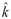
Comparison of SIS epidemic dynamics on networks with different statistical properties.Grey lines show 500 stochastic realizations of the individual-based model run on different random networks. Colored lines show the mean dynamics expected under the pairwise epidemic model (blue) versus the random mixing model (red). (a-c) Homogenous networks with varying overall connectivity k^. (d-f) Homogenous networks with different clustering coefficients ϕ but fixed degree k^=4. (g-i) Heterogenous networks with constant mean degree μk = 4 but with different variances σk2 in the degree distribution. (j-l) Heterogenous networks with different assortativity coefficients r. To allow for greater assortativity, the mean and variance of the degree distribution was raised to six. For all simulations the network size N = 250, the transmission rate τ = 0.5 and the recovery rate ν = 0.1. The transmission rate β under random mixing was scaled so that the rate of infectious contacts was the same as under the pairwise epidemic model at t = 0, giving the two models the same intrinsic growth rate.